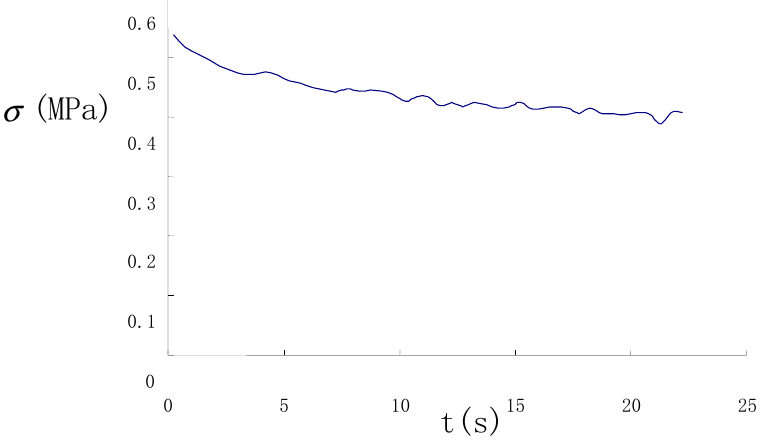
Figure 7. Stress-time history under control of strain.